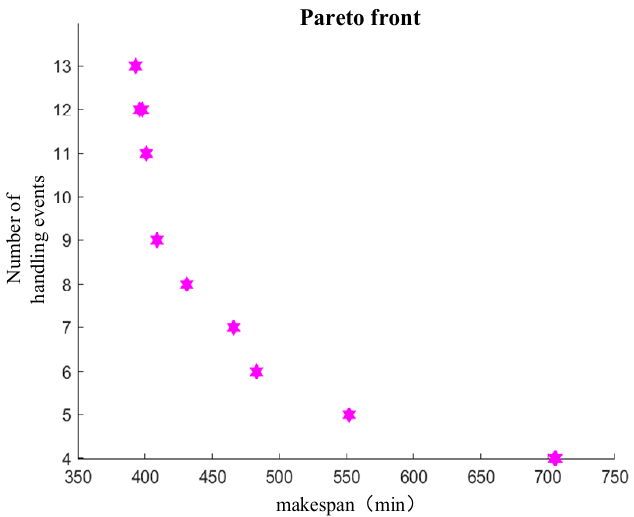
Figure 9. Pareto front.